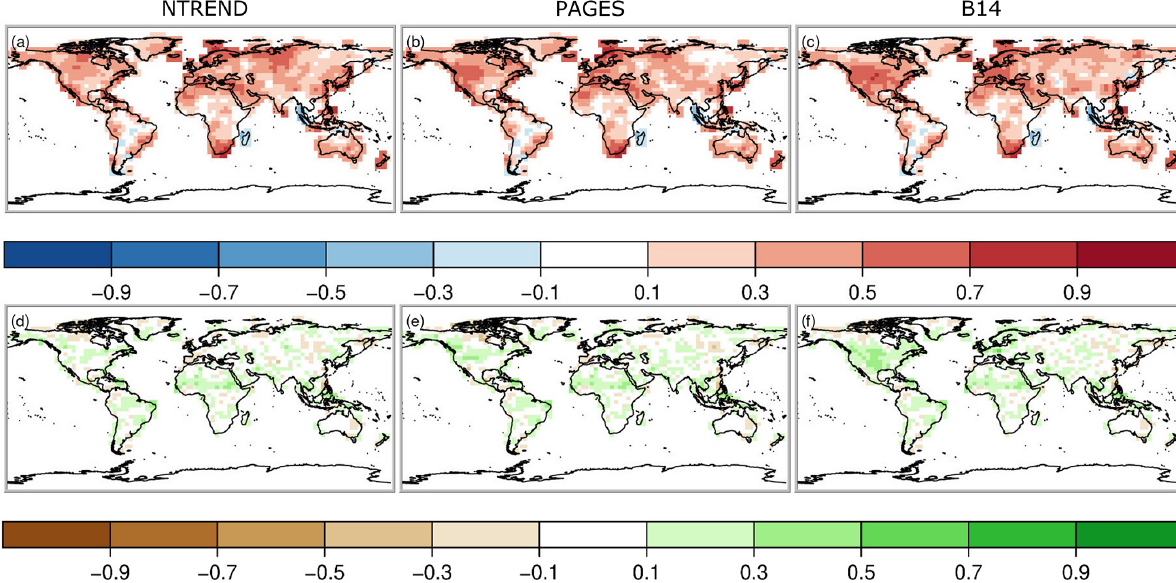
Figure 2. Pearson correlations coefficients between the analysis and gridded instrumental data in the 20th century. Panels (a) , (b) and (c) show temperature and the (d) , (e) and (f) precipitation correlation. This figure shows results from experiments 1 to 3 (Table 1), i.e., after assimilation of the three proxy data collections using the proxy system model that assumes only growth limitation by temperature.